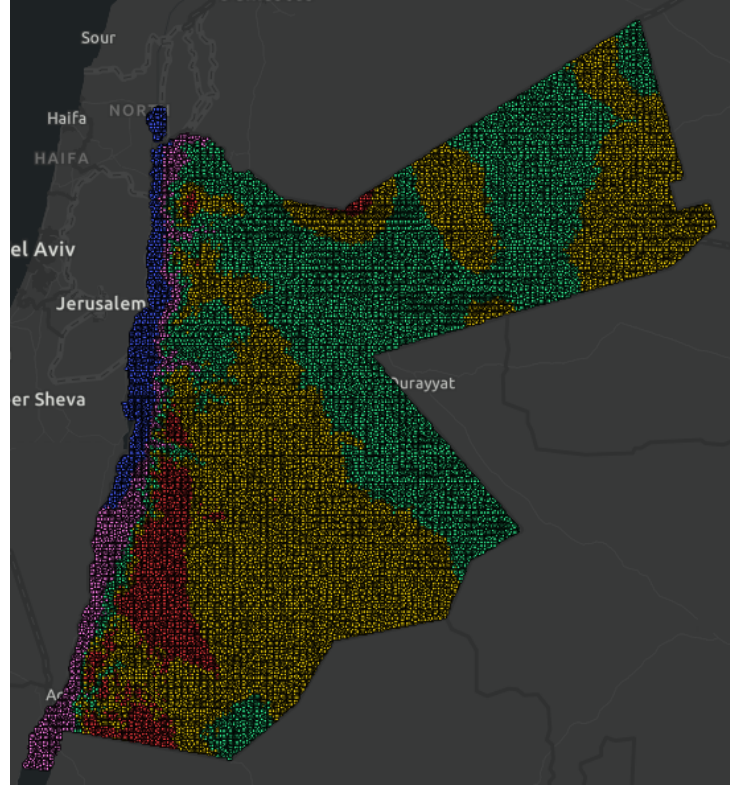
Figure 6. Elevation clustering in Jordan with k = 5. Table 3. Clusters information with K = 5.